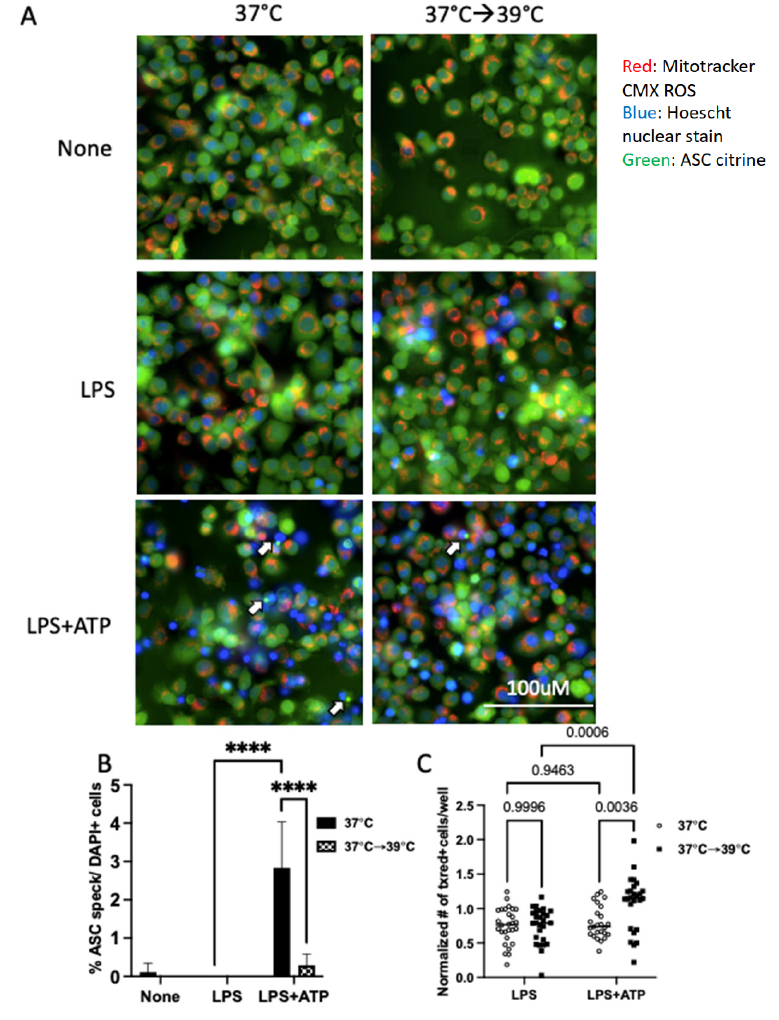
Figure 4. Mild heat shock inhibits the formation of ASC specks but does not inhibit mitochondrial membrane potential. ( A ) Representative images of iBMMs expressing ASC-citrine stained with Mi- totracker CMX ROS and Hoescht nuclear stain show inhibition of ASC specks (white arrows) and increased numbers of cells with polarized mitochondria in heat-exposed cells. Live cells were imaged using the IXM live cell microscopy system. Images are from a representative experiment. ( B ) Quanti fi cation of ASC specks per DAPI nuclei. Results are a representative experiment of 3 independent experiments, counted manually with >5 (40×) fi elds/conditions. ( C ) Quanti fi cation of the number of cells/well with respiring mitochondria, normalized to the unstimulated 37 °C control condition, greater than 16 wells/condition/experiment combined over three independent experiments. **** p < 0.0001 as determined by a two-way ANOVA with Tukey’s multicorrection comparison; ns, nonsigni fi cant.